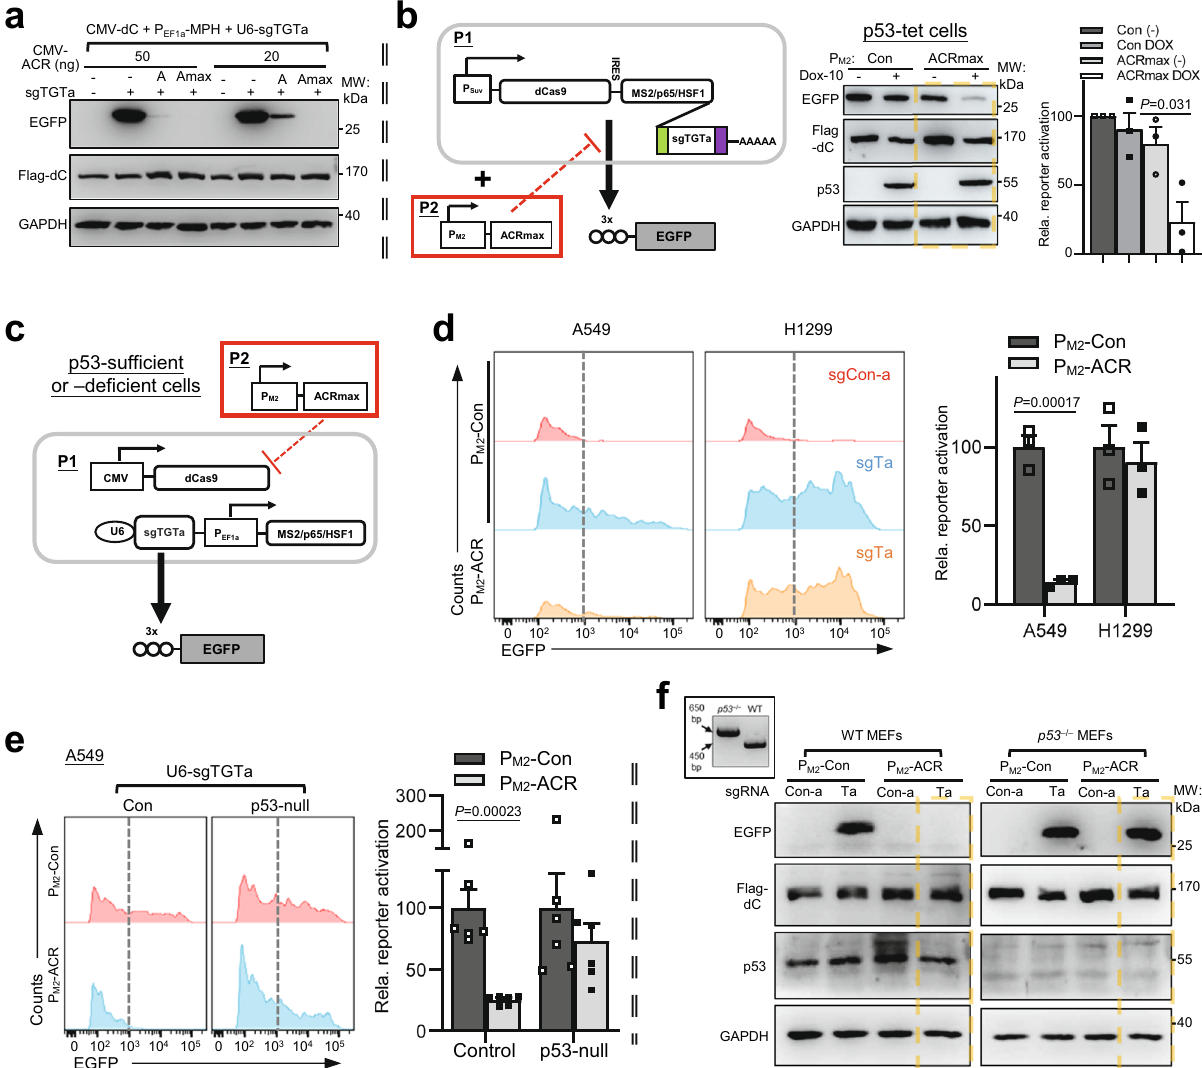
Fig. 4 Development of a more accurate NOT gate for CRISPRa by employing the anti-CRISPR AcrIIA4. a 293T cells were co-transfected with the AcrIIA4 in bacterial codons [ “ A ” ] or its human codon-optimized version [ACRmax, “ Amax ” ] (both under CMV promoter), and the constitutively expressed SAM components. Thirty-six hours after transfection, cell lysates were harvested and subjected to IB for levels of EGFP and Flag-dCas9. b The p53-tet H1299 cells were transfected with a single promoter-driven CRISPRa expression unit targeting an EGFP reporter, and ACRmax led by P M2 (illustration on the left, P Suv : survivin promoter). The effects of DOX (10 ng/ml) treatment were analyzed by IB (middle). Quantitation of EGFP band intensities (normalized to those of GAPDH) is shown on the right (mean ± SEM, n = 3 measurements from independent experiments). c , d In c , the illustration shows the circuit featuring a strong CRISPRa actuator (CMV-dCas9 and U6-sgTGTa for EGFP), and an inhibitory module of P M2 -ACRmax. In d , the circuit was introduced into A549 and H1299 cells. A non-targeting sgRNA (sgCon-a) was the control. A representative histogram shows the fl uorescence pattern for EGFP + cells ( “ Ta ” : sgTGTa). The dotted lines mark high levels of EGFP positivity de fi nitively attributed to CRISPRa. The quantitation is shown next to the histogram (EGFP + %×MFI, mean ± SEM, n = 3 biological replicates). e Isogenic clones (six each) of WT or p53-de fi cient A549 cells were prepared after CRISPR/Cas9-mediated genome editing. The circuit in c was introduced into the cells and their EGFP signals were determined by fl ow cytometry (left). The dotted lines highlight p53/P M2 -ACR-driven inhibition of CRISPRa activities. The quantitation for fl uorescence (EGFP + %×MFI) is presented on the right (mean ± SEM, n = 6 independent WT and p53 − / − cell lines transfected in parallel). f WT or p53 − / − MEFs were prepared. The inset shows a representative genotype analysis. The circuit in c was introduced to the cells (sgCon-a as a control). The cell lysates were subjected to IB. One-sided Student ’ s t -tests were used for statistical analyses in this fi gure ( P values provided). Blotting results in ( a – c ) are representative of 2, 3, and 2 independent experiments, respectively. Source data are provided in the Source Data fi